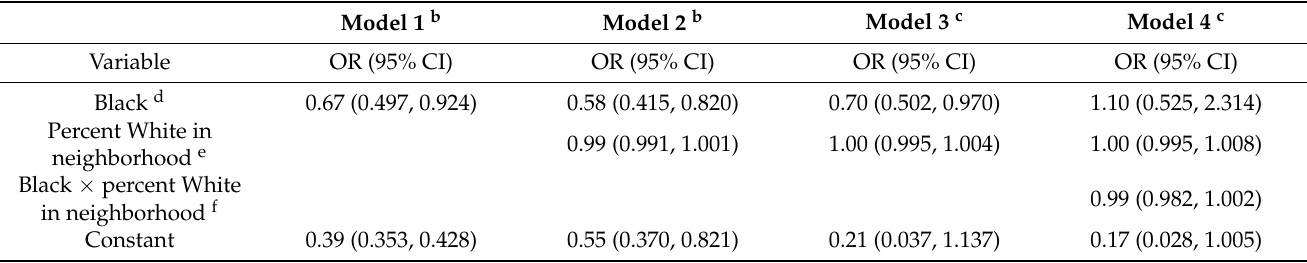
Table 2. Logistic regression of odds of having ideal CVH a among 5080 adult male participants, Add Health (Wave IV).